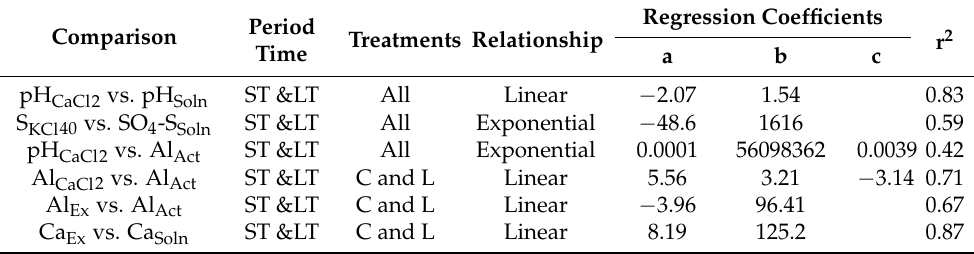
Table 1. Regression coefficients for the relationship between soil and soil solution measurements of pH, SO 4 -S, Al and Ca across the control (C), lime (L), gypsum (G) and L + G treatments in the short term (ST) and long-term (LT). The soil measurements examined were pH, and Al were measured using 0.01 M CaCl 2 (pH CaCl and Al CaCl ), exchangeable Al (Al Ex ) and SO 4 -S extracted by 0.25 M 2 2 KCl heated for 3 h at 40 ◦ C. The soil solution measurements using a paste extract to measure